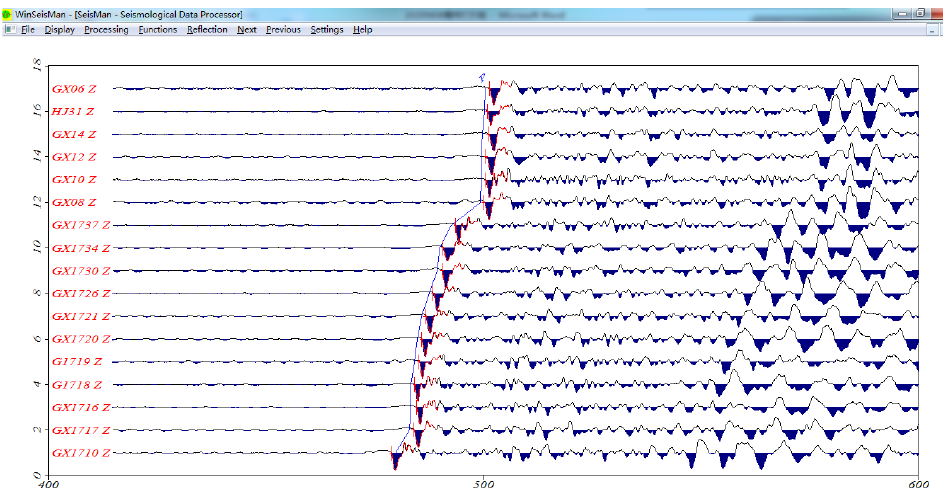
Figure 11. Results of fine-tuned cross-correlation.